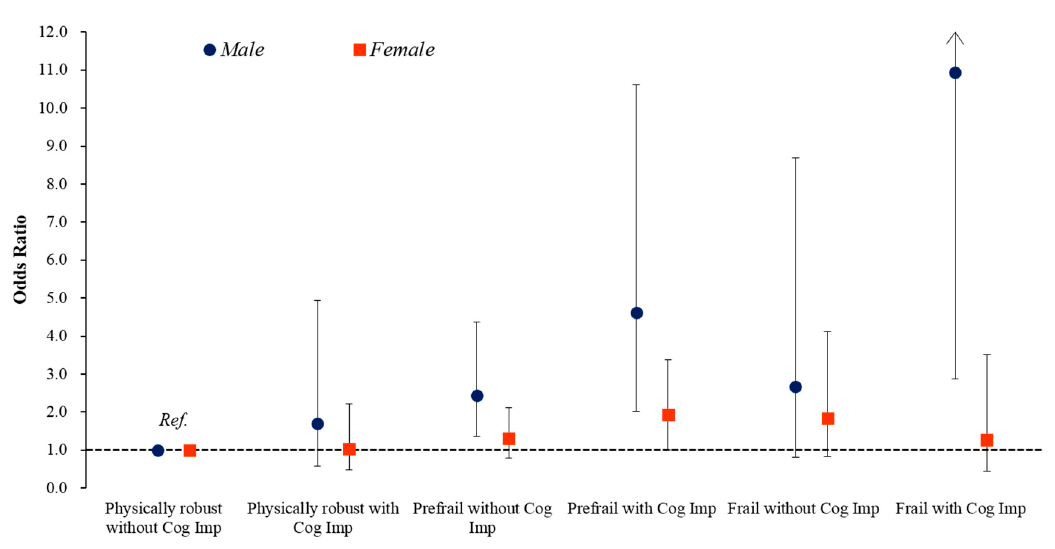
Figure 3. Association between low calf circumference (<32 cm) and cognitive frailty status. Odds ratios (95% confidence intervals) were calculated by Firth’s penalized likelihood of logistic regression after adjustment for age, alcohol, years of education, comorbidity, medication, and body mass index.